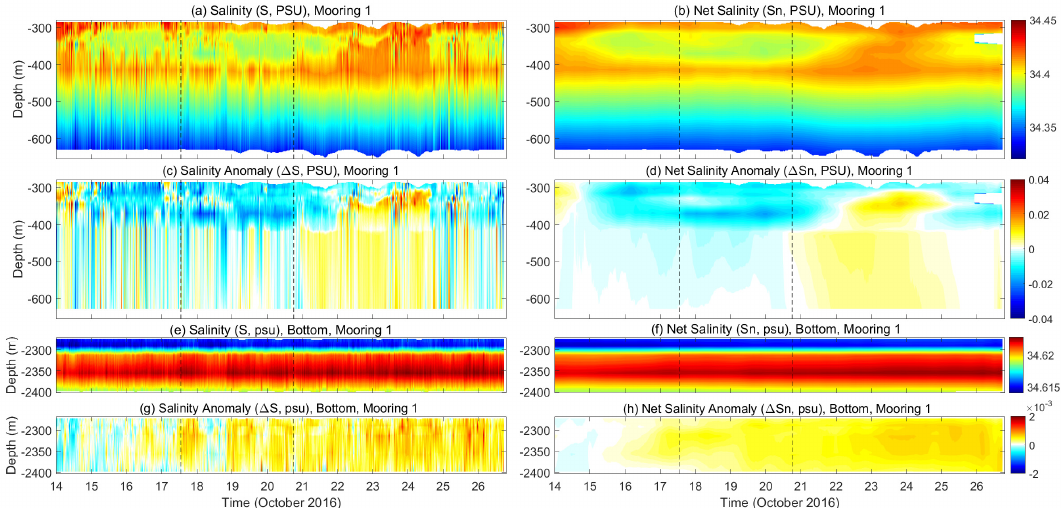
Figure A4. Variations in the salinity and net salinity in the inner ( a – d ) and bottom ( e – h ) ocean at Mooring 1 during Sarika and Haima.